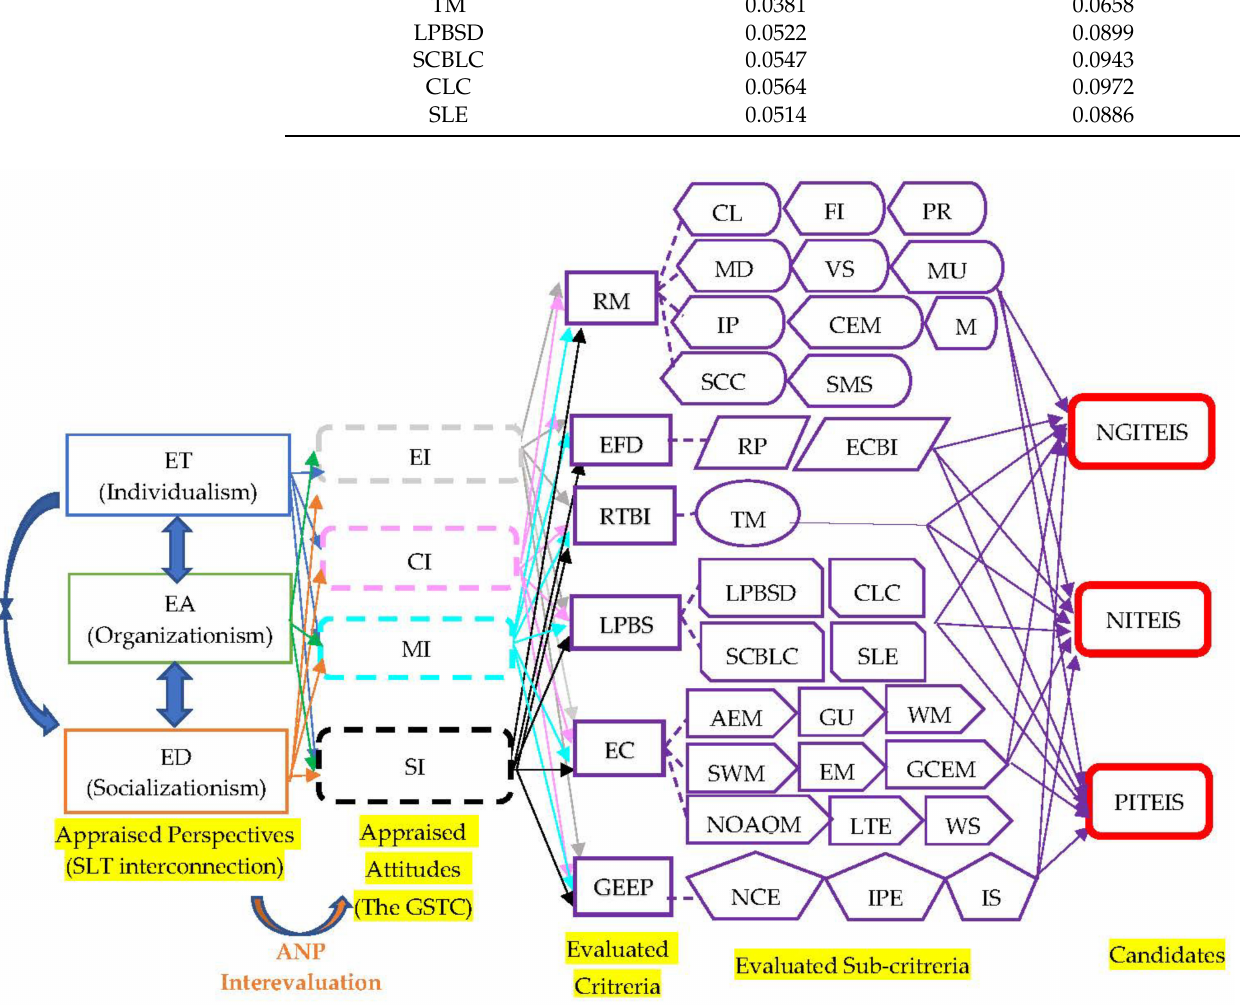
Figure 3. The ANP-evaluated